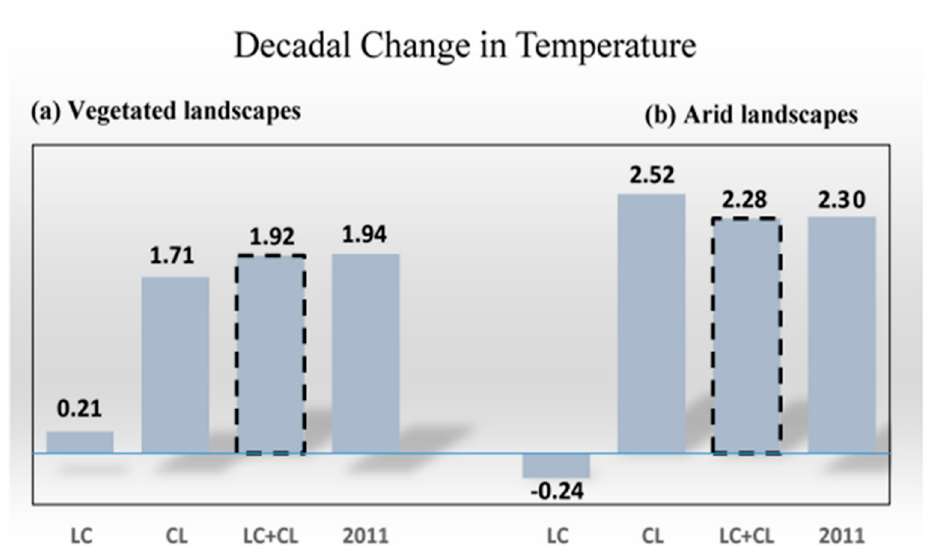
Figure 2. Decadal change in surface temperature (°C) between 2001 and 2011 for the three model simulations. Land cover only (LC), climate only (CL) and combined climate and land cover (2011). The dashed bar is obtained by linearly adding the impact of land cover only (LC) to that of climate only (CL). The change is illustrated for urban centers built within ( a ) vegetated landscapes and ( b ) arid landscapes. In both regions the impact of urban-induced land cover change is linearly additive to that of climate.